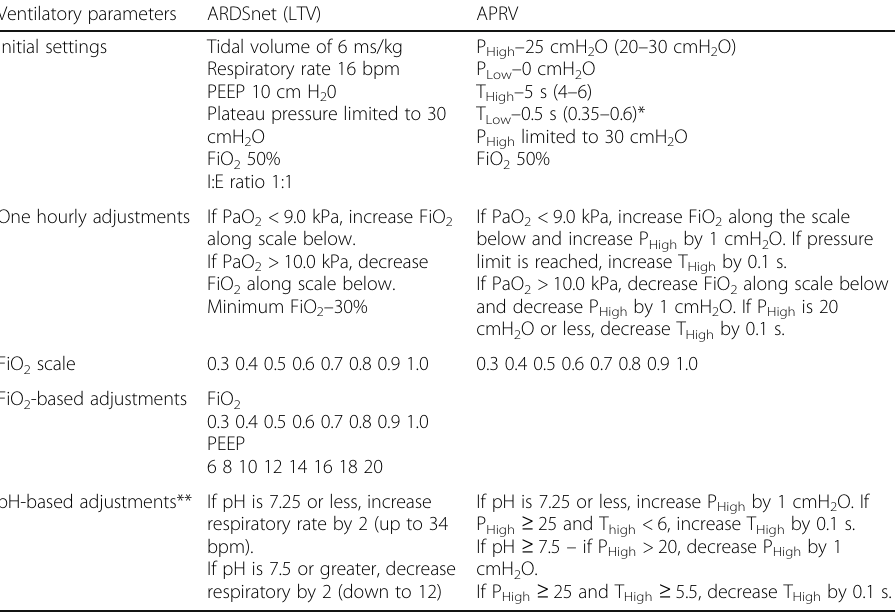
Table 2 Ventilatory protocol applied by the simulator over the 24-h duration of the study Ventilatory parameters ARDSnet (LTV) APRV Initial